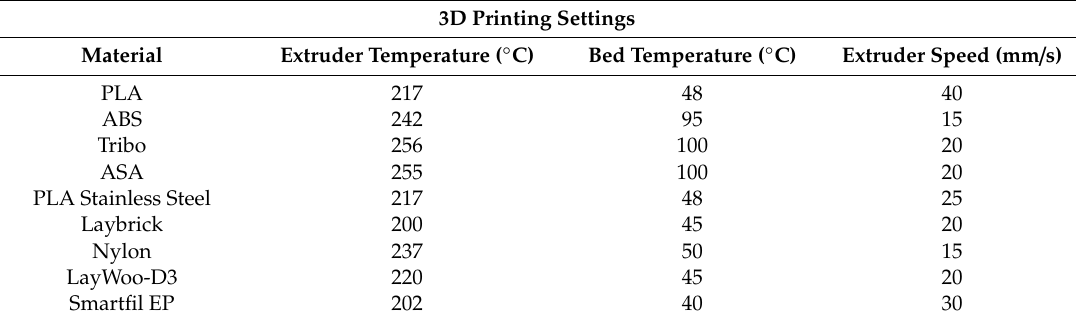
Table 1. Printing parameters of the used materials in the BQ Hephestos printer.